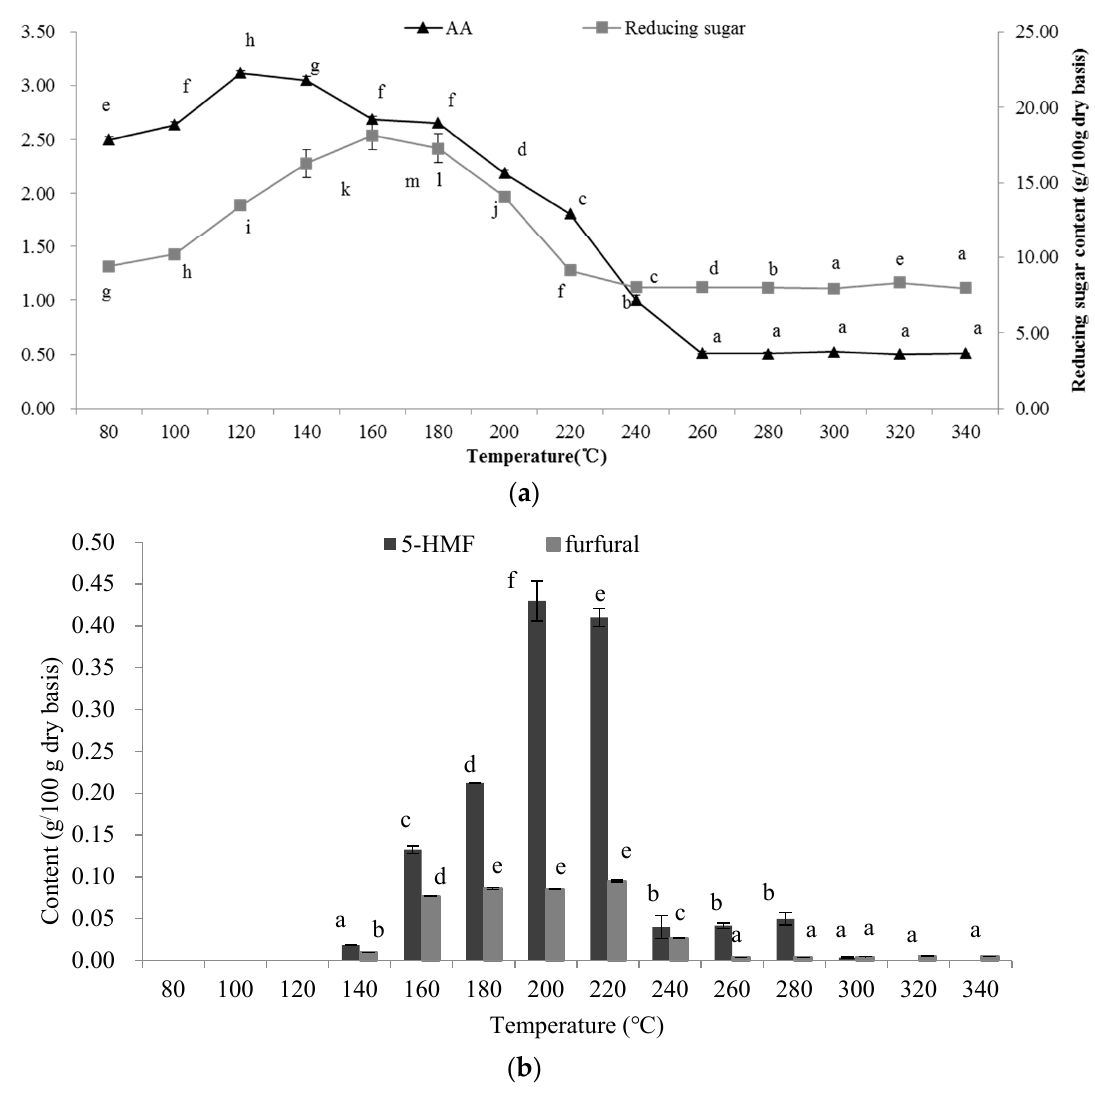
Figure 4. The analysis of indicators of Maillard reaction in the extracts at different temperatures, ( a ) total reducing sugars and total amino acids contents; ( b ) 5-HMF and furfural contents. The results are expressed as the mean ± standard deviation ( n = 3); different letters indicate significant differences ( p < 0.05), and the same letters indicate insignificant differences.